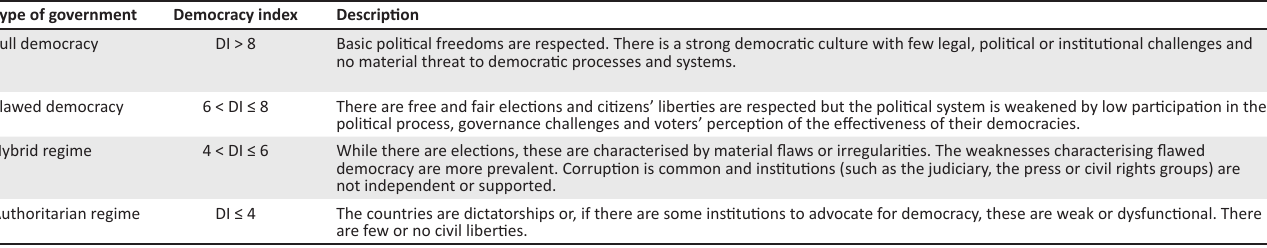
TABLE 1: Categories of political